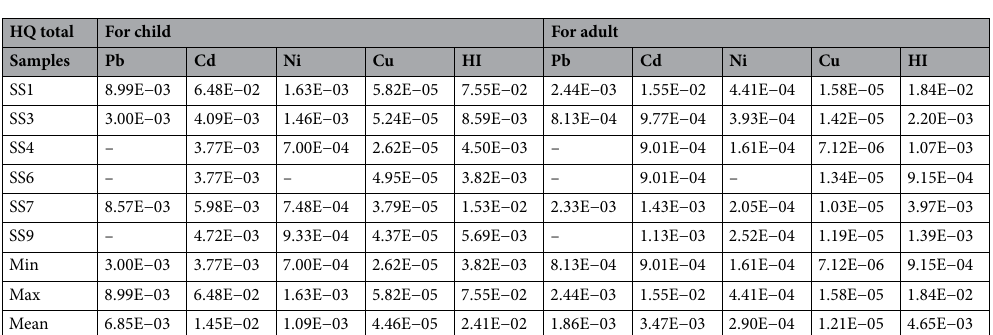
Table 9. The HQ and hazard index (HI) value of noncarcinogenic analysis of the